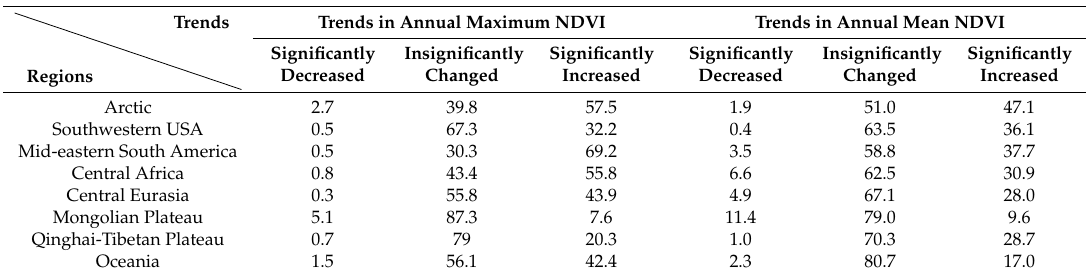
Table 2. The area proportion (%) of different change trends in the annual maximum and mean NDVI of OGFD ecosystems in different regions from 1982 to 2011.